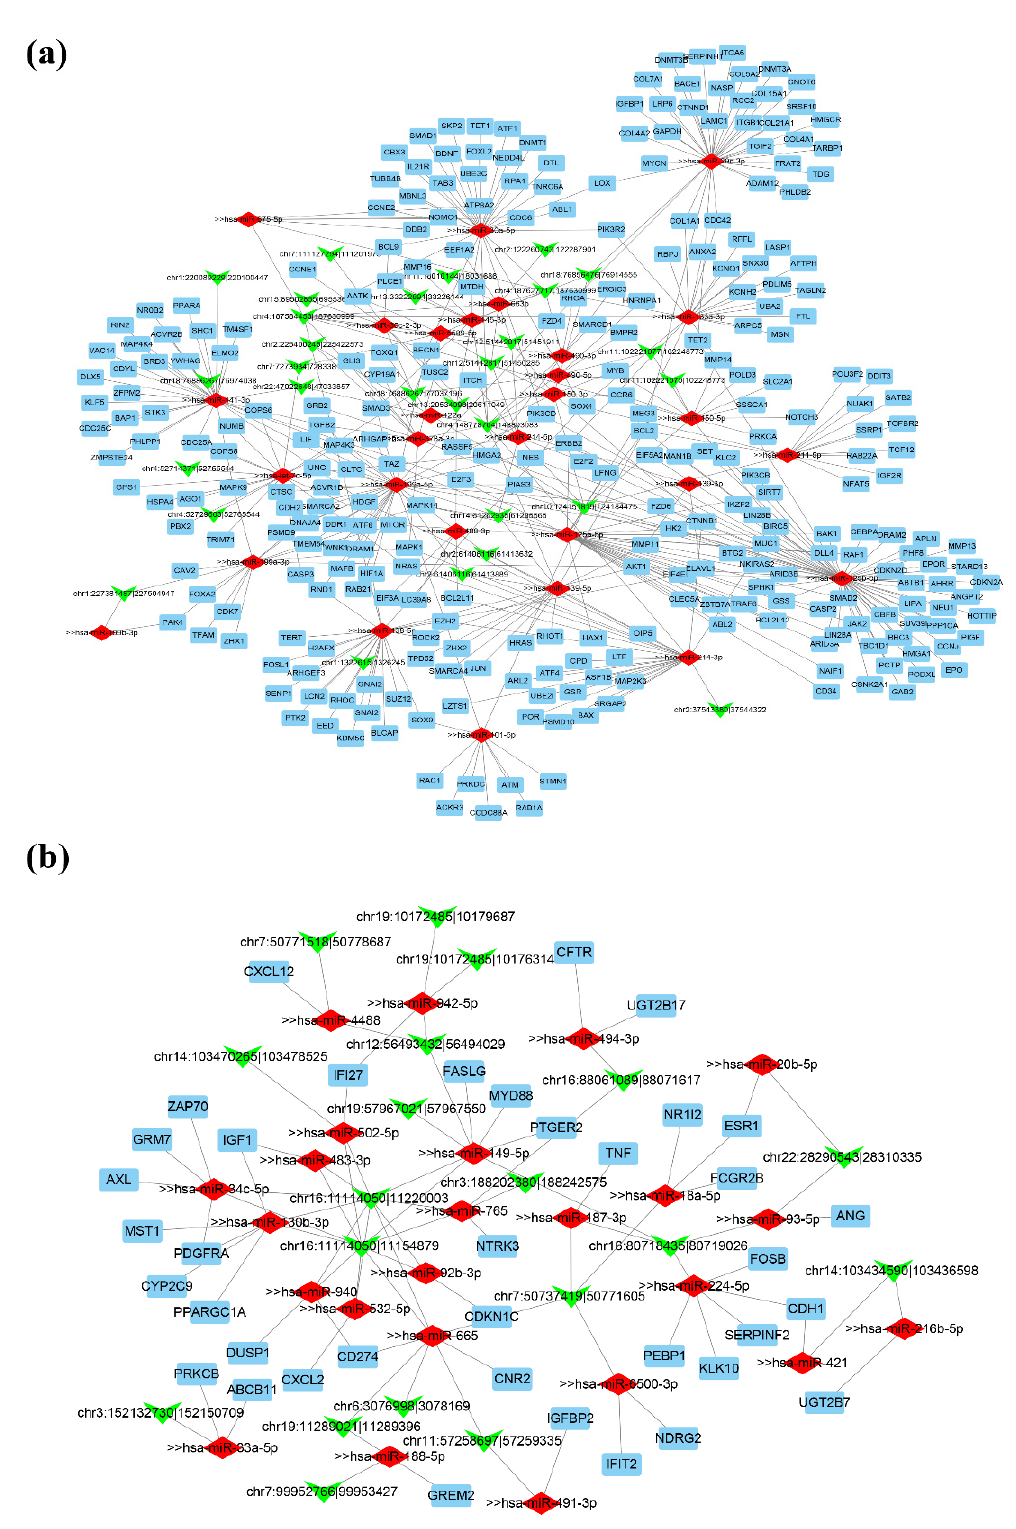
Figure 6. Competing endogenous RNA (ceRNA) regulatory network. ( a ) The network consists of 29 upregulated circRNAs harboring differentially methylated sites, 29 downregulated microRNAs, and 299 upregulated mRNAs. ( b ) The network consists of 19 downregulated circRNAs harboring differentially methylated sites, 22 upregulated microRNAs, and 38 downregulated mRNAs. Green, red, and blue nodes represent circRNAs, microRNAs, and mRNAs, respectively. Edge denotes their relationship.